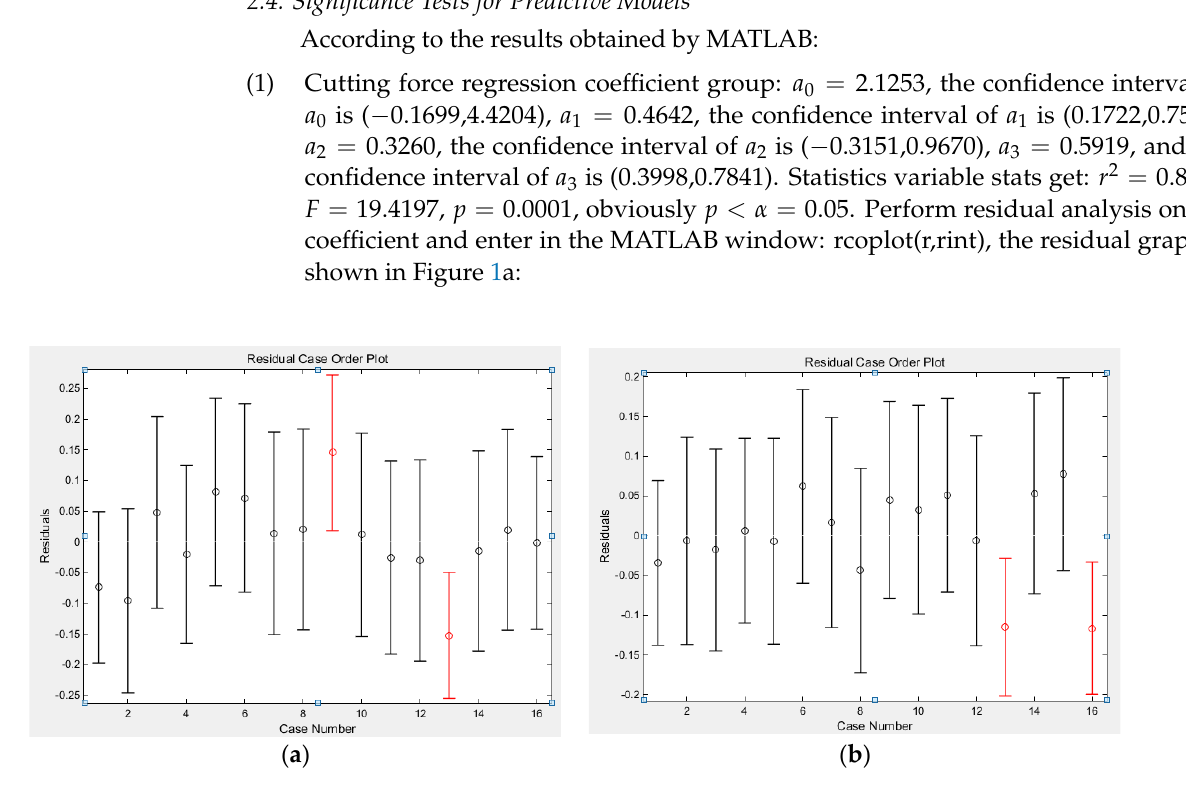
Figure 1. Residual analysis graph. ( a ) Analysis of residual cutting force. ( b ) Analysis of residual cutting temperature. cutting